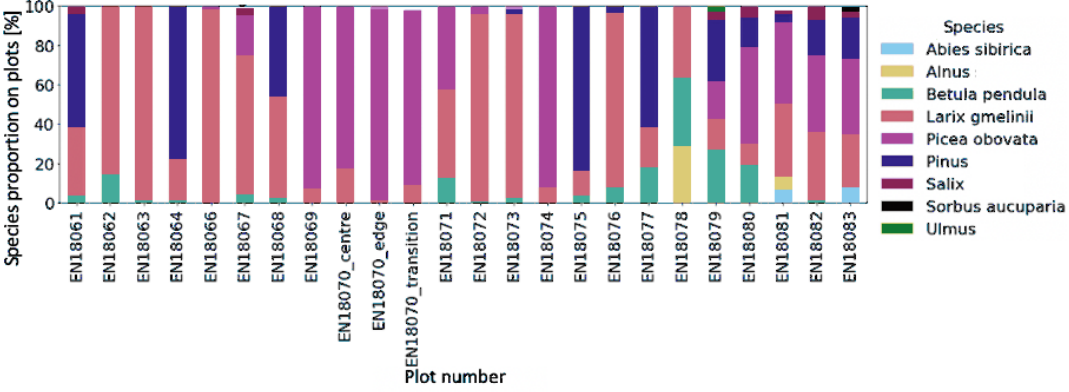
Figure A3. Percentage vegetation cover per plot in Yakutia for only large shrubs and trees ( > 1.3m).